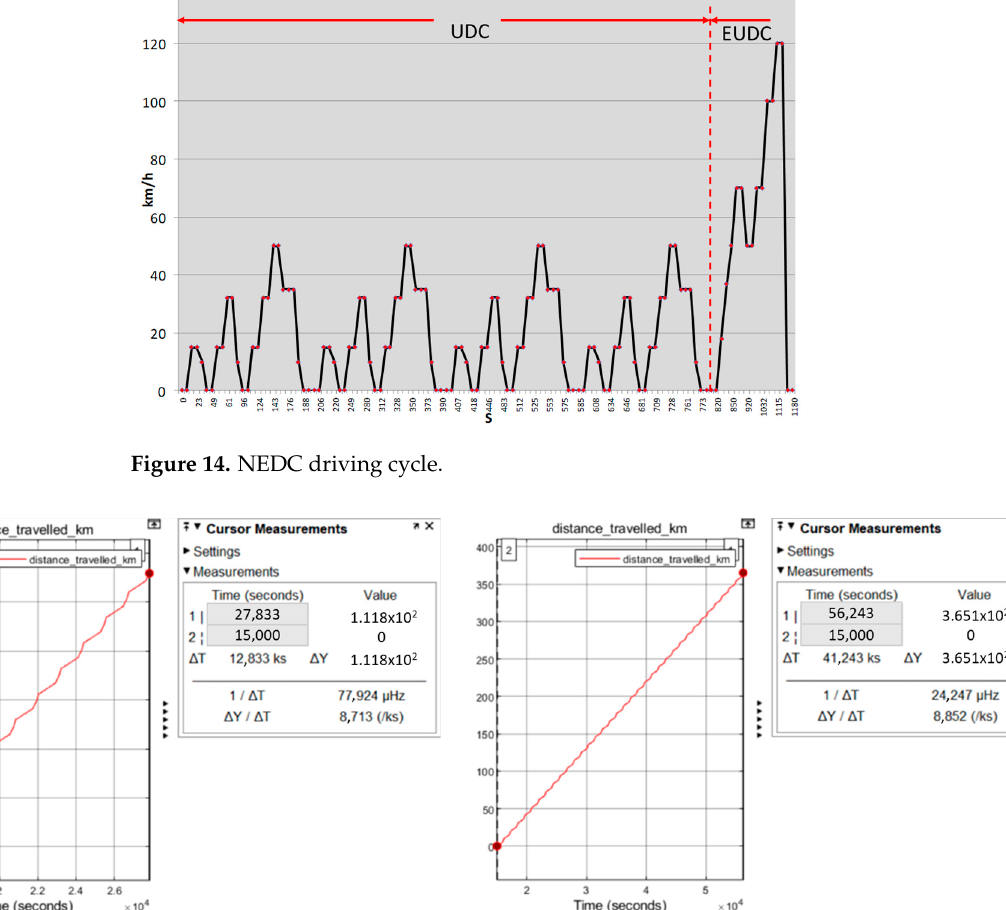
Figure 14. NEDC driving cycle.